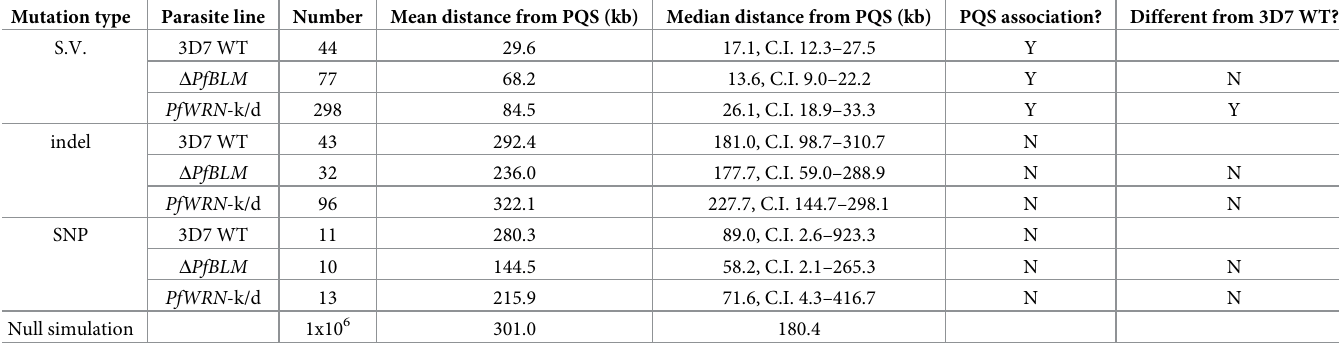
Table 1. Analysis of association between mutation events and